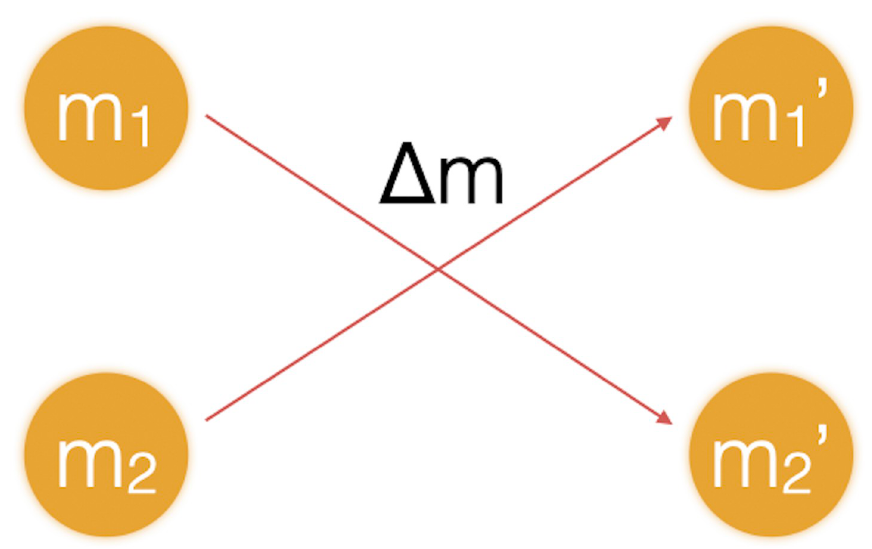
Fig 2. Agent exchange. Agents with wealth m 1 , m 2 at time t interact and exchange money Δ m in the process, resulting ; m 0 at time t + in agents with wealth m 0 1 2